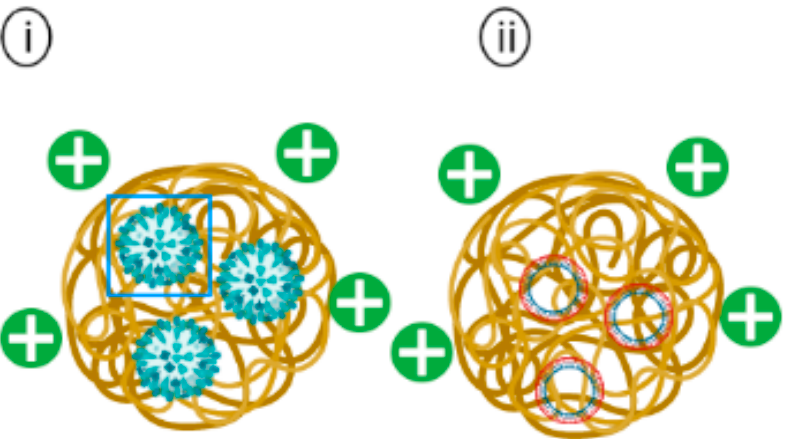
Figure 6. Schematic representation of ( i ) Chitosan encapsulating inactivated whole influenza virus and ( ii ) Chitosan encapsulating plasmid DNA vaccine.